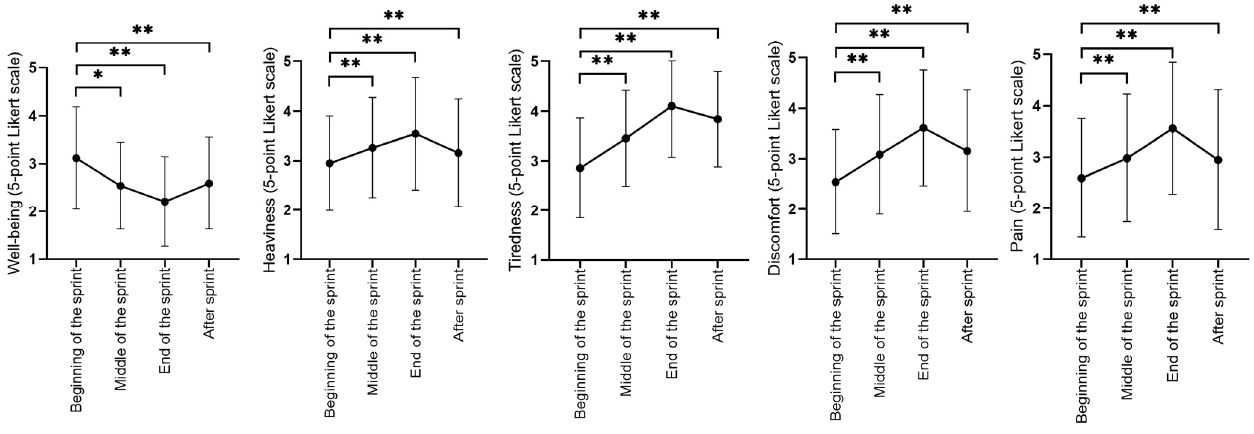
Figure 3. Behavior of perceptions during the 100-m freestyle sprint (* = p < 0.05, ** = p < 0.01). Pain Both massage groups had fewer chances of reporting no pain at the main series on the third day compared to the first (SM Exp(B) = 0.09 CI 95% = 0.02 to 0.35 p < 0.01, DM Exp(B) = 0.27 CI 95% = 0.07 to 1.05 p = 0.05), whereas CON had more chances of reporting no pain at the first stages of the swim training on the third day compared to the first (dur- ing swim warm-up, Exp(B) = 3,25 CI 95% = 1.04 to 10.23 p = 0.04, and after swim warm- up, Exp(B) = 4.74 CI 95% = 1.27 to 17.65 p = 0.02) (Figure 4A). Heaviness DM has more chances of reporting extreme heaviness after the main series on the second day compared to the first (Exp(B) = 6.71 CI 95% = 2.35 to 19.13 p < 0.01) (Figure 4B). Well-being CON had fewer chances of reporting extremely well until the end of swim training on the third day compared to the first (after resistance training Exp(B) = 0.43 CI 95% = 0.19 to 0.96 p = 0.04, after intervention Exp(B) = 0.34 CI 95% = 0.15 to 0.81 p = 0.01, during swim warm-up Exp(B) = 0.18 CI 95% = 0.08 to 0.42 p < 0.01, after swim training Exp(B) = 0.22 CI 95% = 0.07 to 0.70 p = 0.01). On the other hand, both massage groups did not report im- portant changes in well-being throughout the week (Figure 4C). Tiredness SM had fewer chances of reporting extreme tiredness at the first stages of the swim training on the third day compared to the first (during swimming warm-up Exp(B) = 0.17 CI 95% = 0.03 to 0.87 p = 0.03, and after swimming warm-up Exp(B) = 0.21 CI 95% = 0.06 to 0.79 p = 0.02). DM had fewer chances of reporting extreme tiredness after intervention (Exp(B) = 0.25 CI 95% = 0.07 to 0.92 p = 0.038) on the third day compared to the first (Figure 4D). Four participants were not sure, whereas fifteen participants already believed in the effects of massage before the trial, and this proportion did not change after study comple- tion. Moreover, all athletes preferred one of the massage protocols over the control, only two preferred SM over DM due to the intensity, and no unintended effects were observed in any of the groups. Because of a competitive event, the training load of one week was significantly reduced. Nonetheless, this happened equally for all groups and Pearson’s correlation showed no important influence of training load over performance (Sprint time r 2 = 0.01 p = 0.16; FINA Points r 2 = 0.004 p = 0.81).